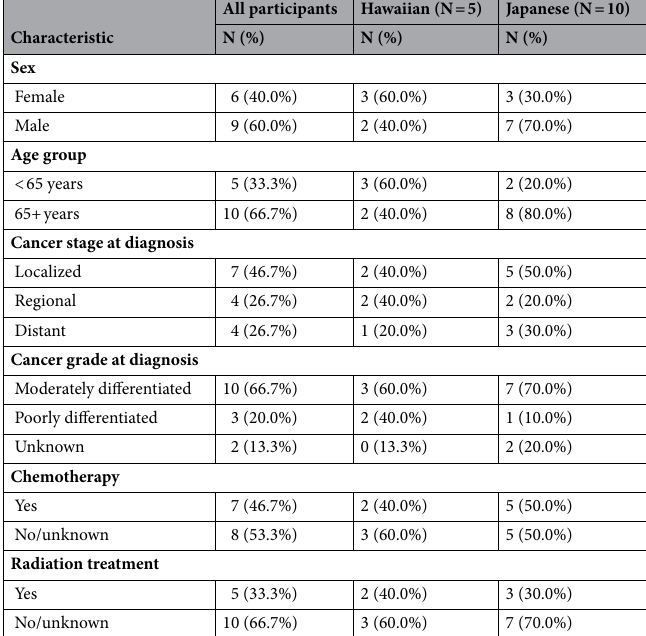
mental Figure S5). GSK3B (FC = − 4.38, p = 2.00E−04), MAPK3 (FC = − 1.92, p = 0.002) and ACTA1 (FC = − 2.30, p = 6.00E−04) were downregulated in the Native Hawaiian cohort compared to the Japanese cohort and these